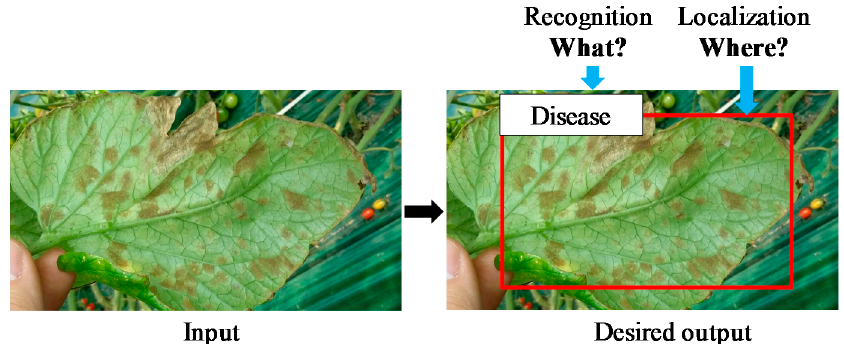
Figure 1. Recognition and localization of plant diseases and pests: problem formulation. Our system aims to detect both class (what) and location (where) of the affected areas in the image.